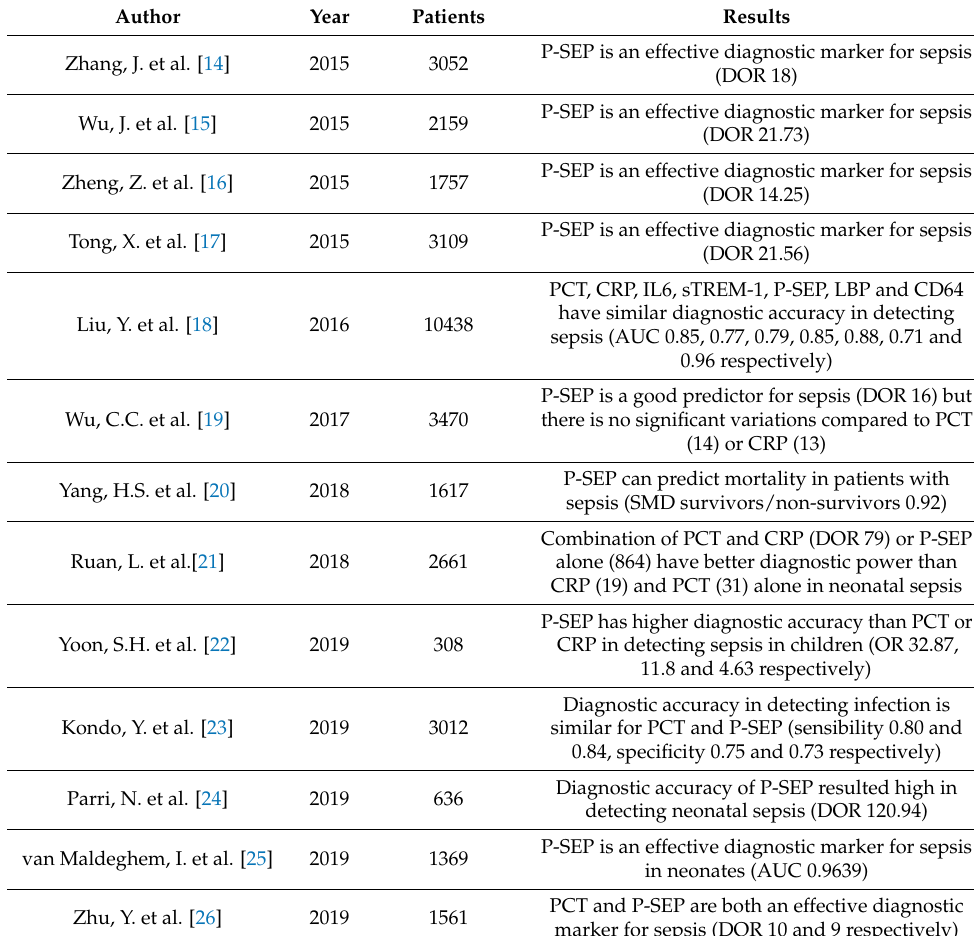
Table 2. Systematic review and